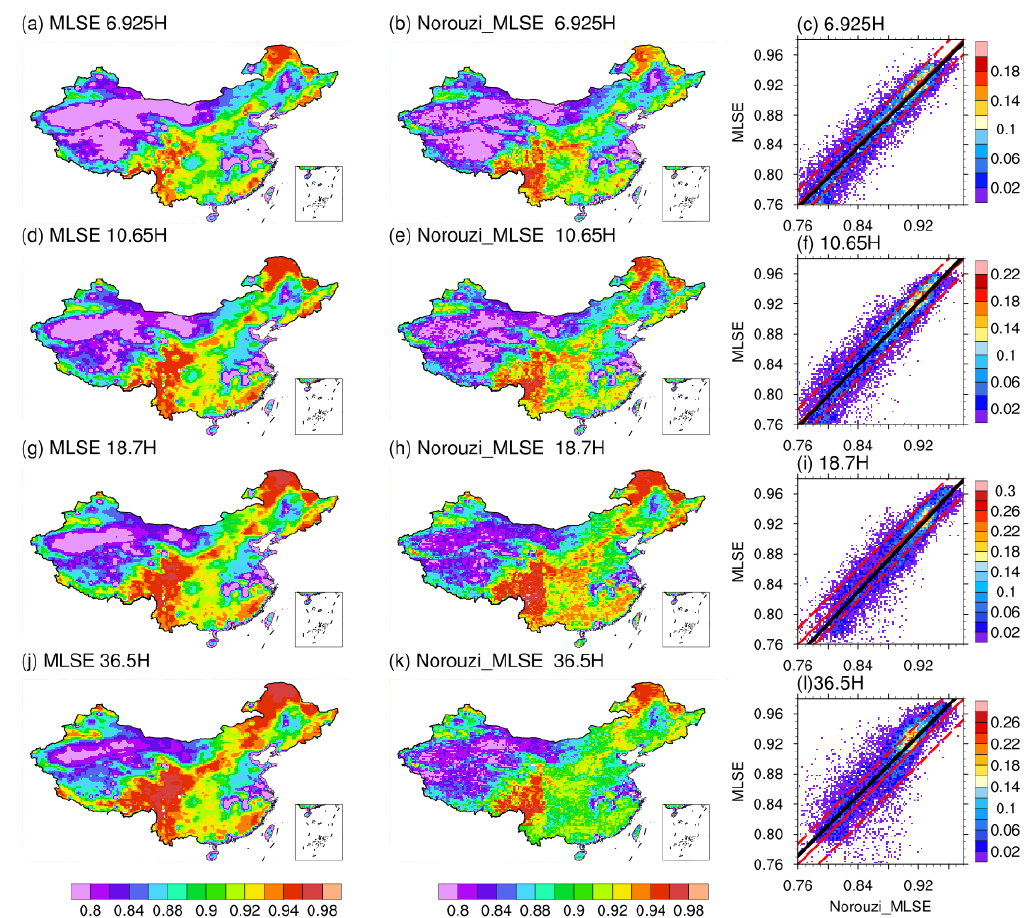
Figure 7. Spatial distributions (0.25°×0.25°) of mean MLSE retrieved in this study (the left panel) and those from the No- rouzi_MLSE product (the mid panel) during summer in 2003, and the corresponding scatter plots between them (the right panel). From top to bottom: the spatial distributions of MLSE at 6.925H, 10.65H, 18.7H, and 36.5H, respectively. Over- lapped in the scatter plots are the RMSE lines (red dashed), 1:1 line (red solid), and the linear regression line (black solid). Table 4. Statistical metrics of comparison of MLSE derived in our study with those from No- rouzi_MLSE in China during summer (JJA) in 2003.